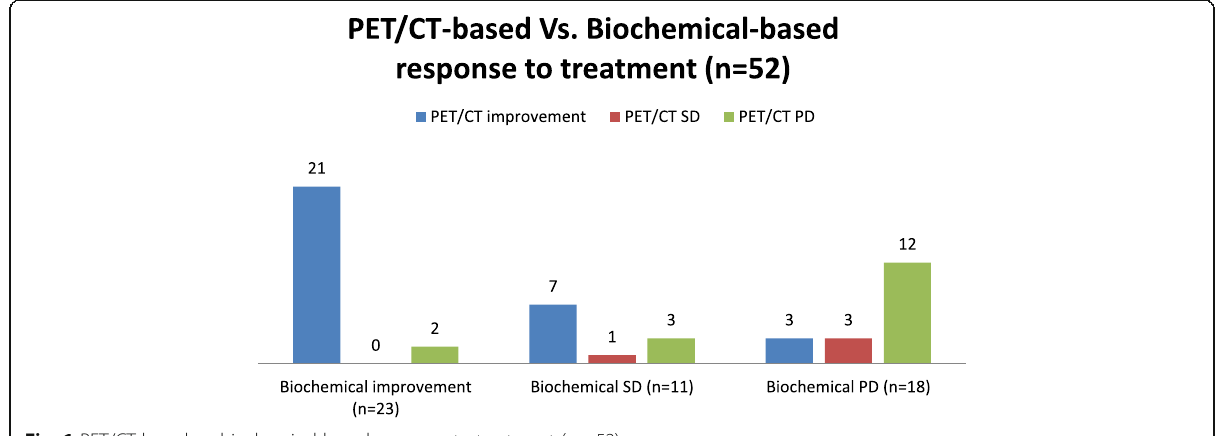
Fig. 1 PET/CT-based vs. biochemical-based response to treatment ( n =